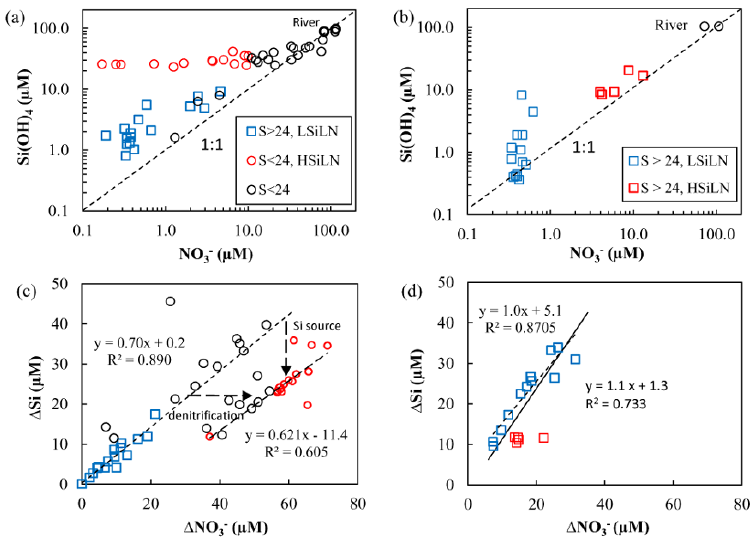
Fig. 6. Relationships between Si(OH) 4 versus NO − for June 2003 (a) and for August 2004 (b) , and between 1 Si versus 1 NO − 3 2003 (c) and for August 2004 (d) . For (c) , the linear regression relationships (dashed lines) for both LSiLN, and HSiLN data. For (d) , the linear regression relationship for LSiLN data (dashed line) and the linear regression relationship for all data (the solid line). Legends for (a, c) are the same as in Fig. 4 and legends for (b, d) are the same as in Fig.